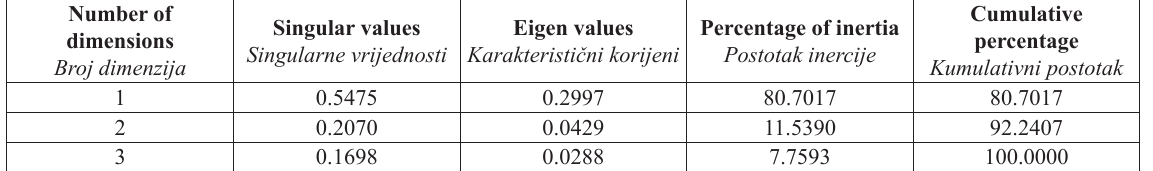
Input table (rows*columns): 4 x 5